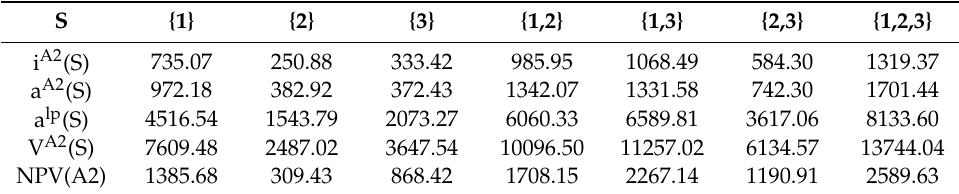
Table 23. Present values of cost and revenues games under Alternative A2.